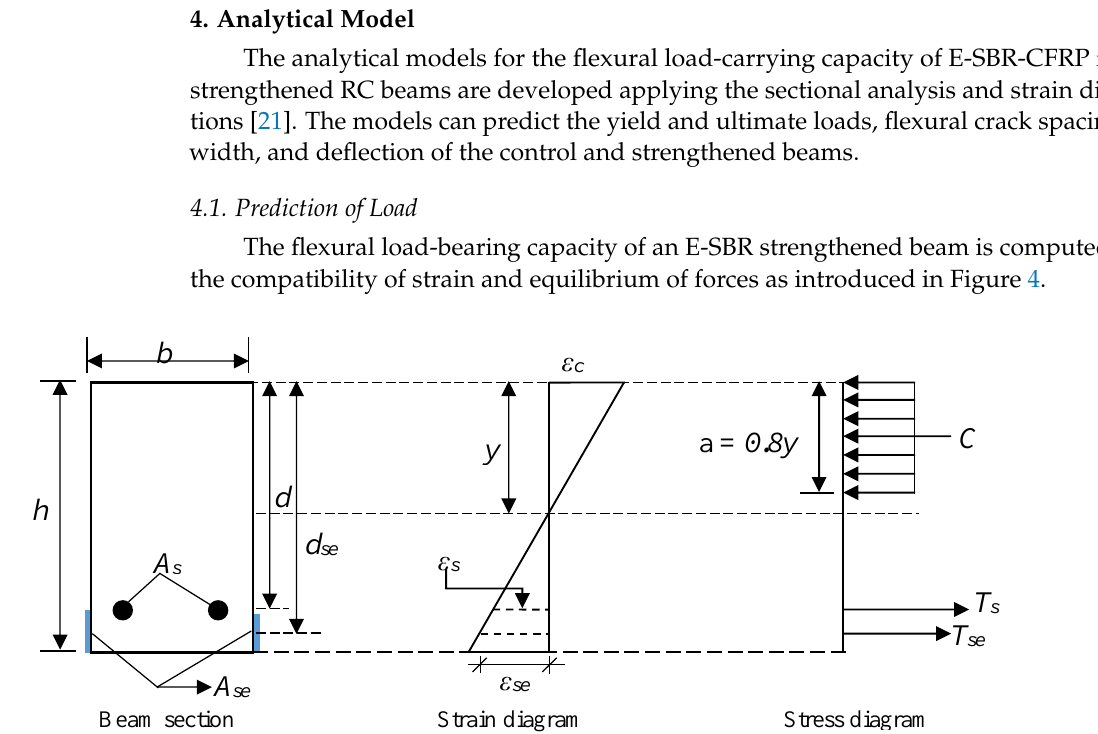
Figure 3. Experimental setup.